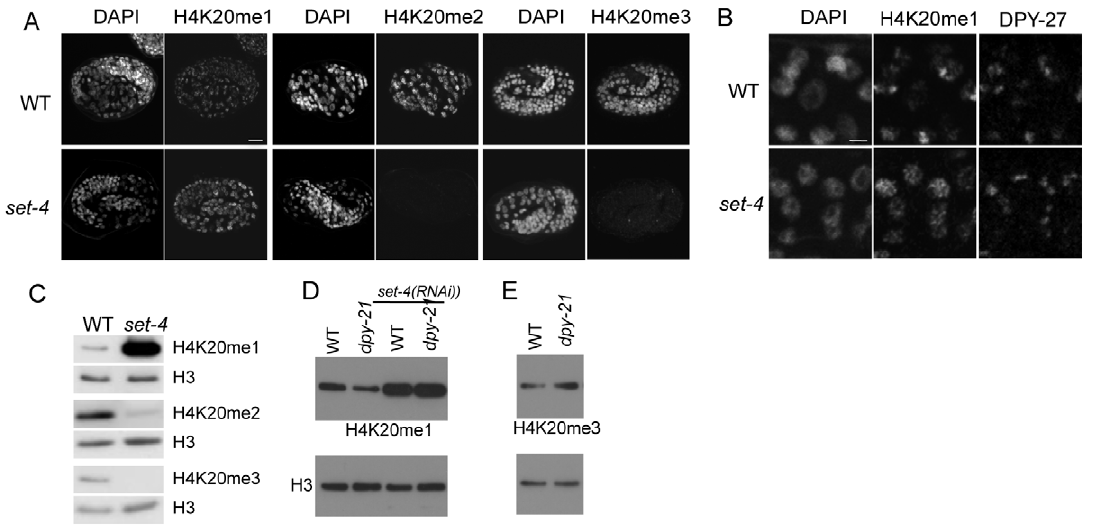
Figure 6. The SET-4 histone methyltransferase is necessary to generate H4K20me2 and H4K20me3. (A) Wild-type (WT) and set-4(n4600) mutant embryos were stained for DNA (DAPI), and H4K20me1, H4K20me2, or H4K20me3. H420me1 levels are higher and H4K20me2 and H4K20me3 levels strongly reduced in set-4 mutant embryos. Scale bar, 10 um. (B) Enlargements of nuclei in wild-type and set-4(n4600) mutant embryos stained for DNA (DAPI), H4K20me1, and DPY-27. In set-4 embryos, H4K20me1 does not show enrichment in DPY-27 positive regions. Confocal settings for H4K20me1 in set-4 were reduced to allow comparison with wild-type images. Scale bar, 2 um. (C) Western blots of extracts made from wild-type and set-4 adults, probed for H4K20me1, H420me2, or H4K20me3. Histone H3 is a loading control. Compared to wild type, set-4 mutants have increased H4K20me1 levels, and reduced H4K20me2 and H4K20me3 levels. (D, E) Western blots of H4K20me1 (D) and H4K20me3 (E) in wild-type and dpy-21 L3 mutant extracts. Lower panels show H3 loading controls. (D) H4K20me1 abundance is lower in dpy-21 than in wild type. (E) H4K20me3 abundance is higher in dpy-21 mutant L3 extract than in wild type. In (D) RNAi of set-4 was additionally performed. H4K20me1 abundance is elevated in both wild- type and dpy-21 after depletion of set-4 . The following primary antibodies were used: H4K20me1 (Diagenode SN-147), H420me2 (Kimura 2E2), H4K20me3 (Abcam ab78517).